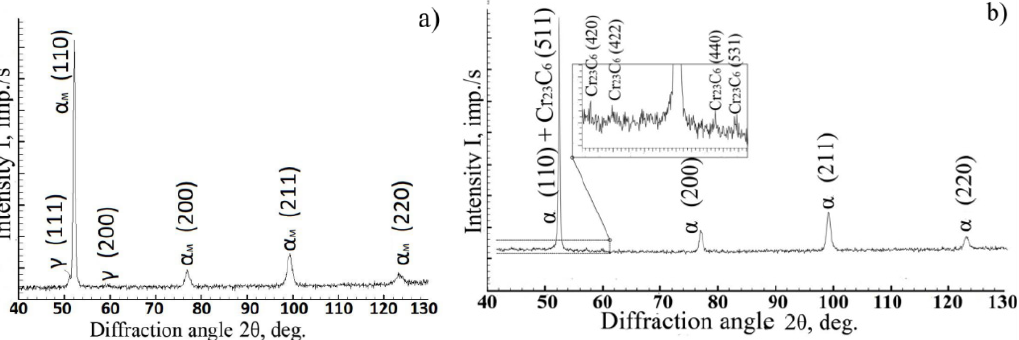
Figure 6. Diffraction patterns of ChS-139 steel after cooling down from 900 °C ( a ) and 885 °C ( b ).